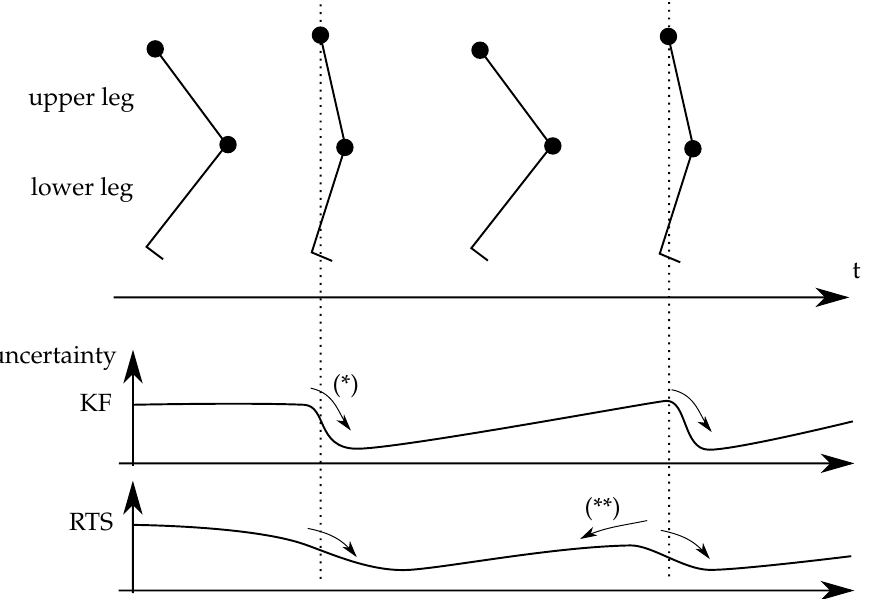
Figure 2. Schematic representation of the advantage of the Rauch Tung Striebel (RTS) compared to a standard KF. A RTS will smooth the uncertainty by using a ’reference’ point (indicated by the vertical dashed line) and by traversing both ways (**), while a KF only traverse in one direction